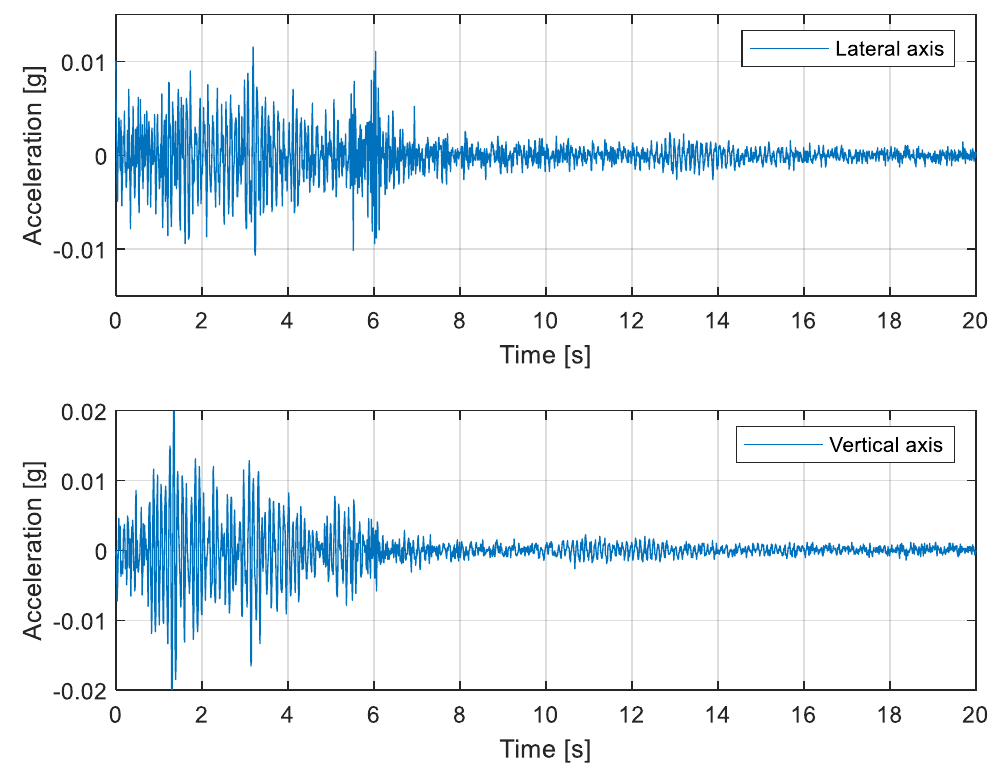
Figure 9. Exemplary acceleration time histories acquired by the wireless sensors triggered by the train passage on the lower deck. Focus on the free response of the structure after the excitation.